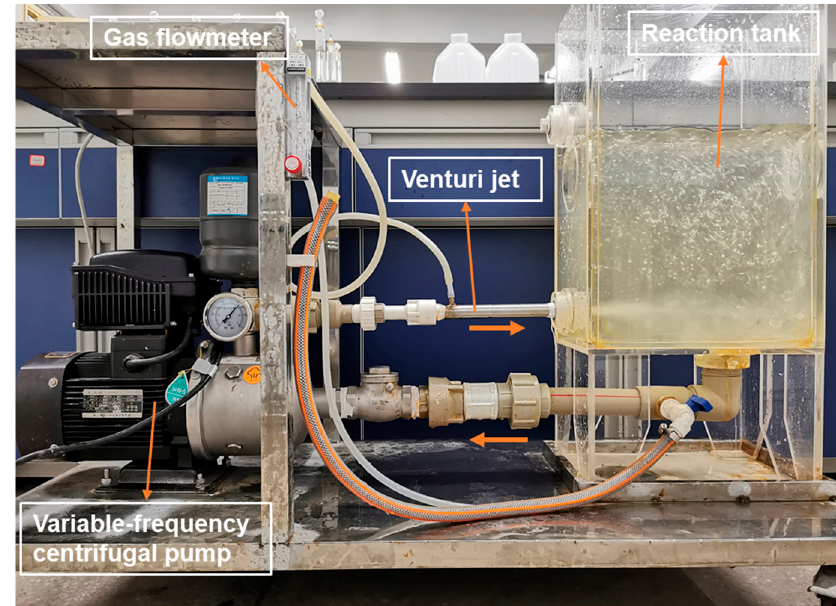
Figure 1. The homemade venturi jet microbubble generator.